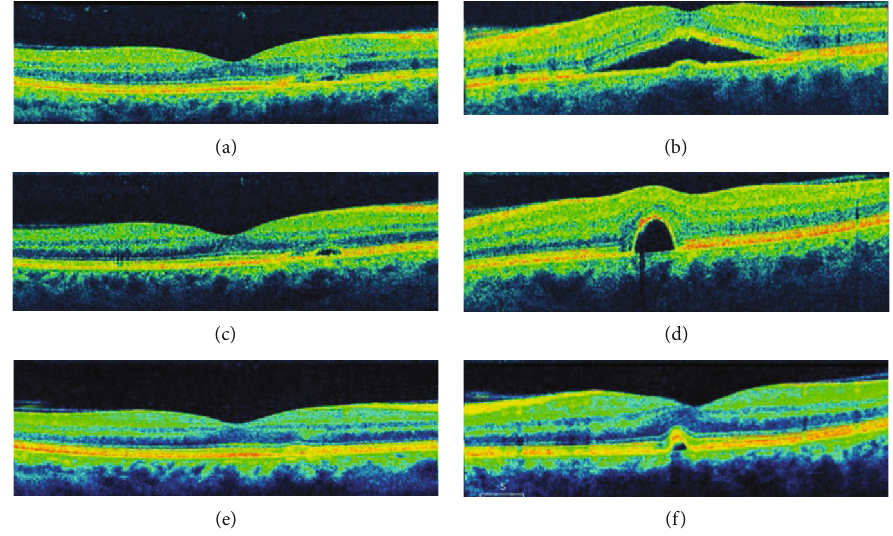
Figure 6: Observation of a patient with bilateral central serous chorioretinopathy. A 52-year-old male with a history of oral corticosteroid use presented with many months of blurred vision, left eye worse than the right eye. The patient was observed every few months without therapy. (a, b) Right and left eye (respectively) optical coherence tomography scans at baseline revealed subretinal fl uid and pigment epithelial disruptions. (c, d) One year later, the left eye subretinal fl uid had resolved but the pigment epithelial detachment was more elevated. (e, f) Two years later, the subretinal fl uid had resolved in both eyes with mild pigment epithelial disruptions. Visual acuity remained stable at 20/20 in each eye throughout this